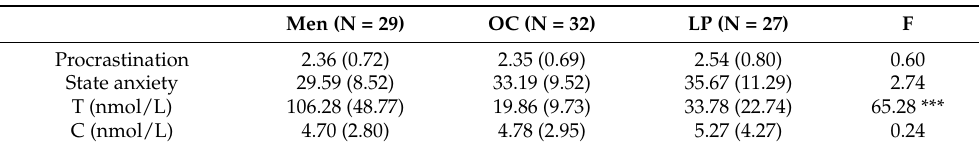
Table 1. Means (standard deviations), F, and p values for group differences in procrastination, state anxiety, and biomarkers (T,